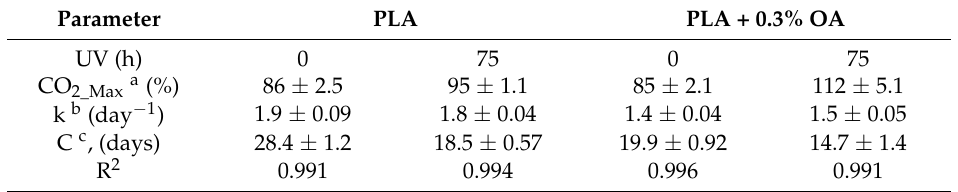
Table 2. Kinetics parameters of the biodegradation obtained from Equation (5).